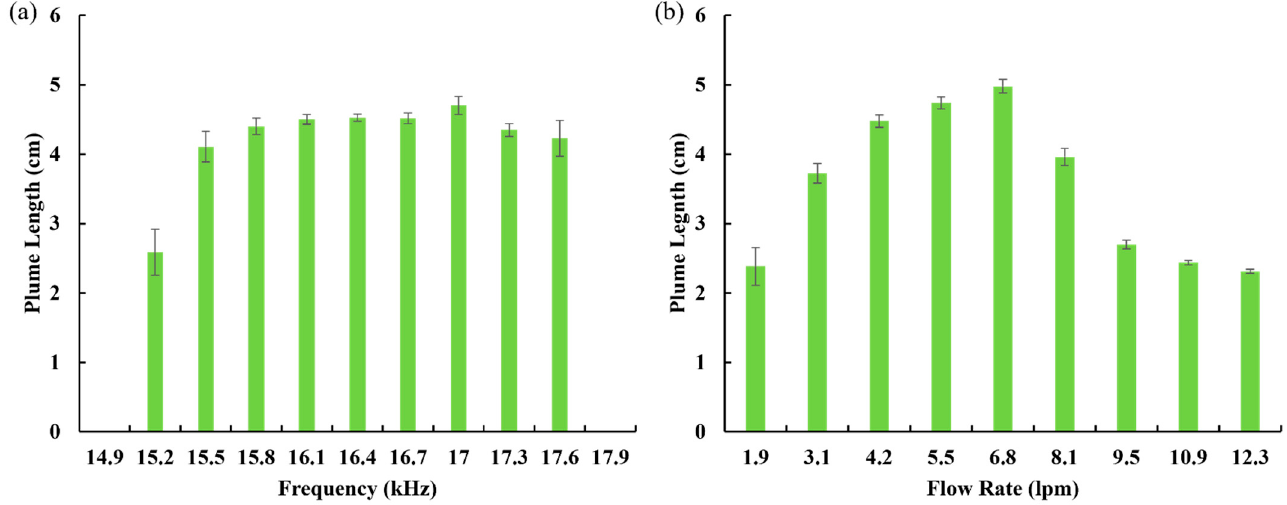
Figure 7. Discharge frequency and helium flow rate strongly affect plasma plume length. ( a ) Discharge frequency effect. Duty cycle and gas flow were held at 25% and 4.2 lpm, respectively. ( b ) Gas flow effect. The duty cycle and discharge frequency were held at 25% and 16 kHz, respectively. All experiments were repeated three times. The results are shown as the mean ± standard deviation (error bar).